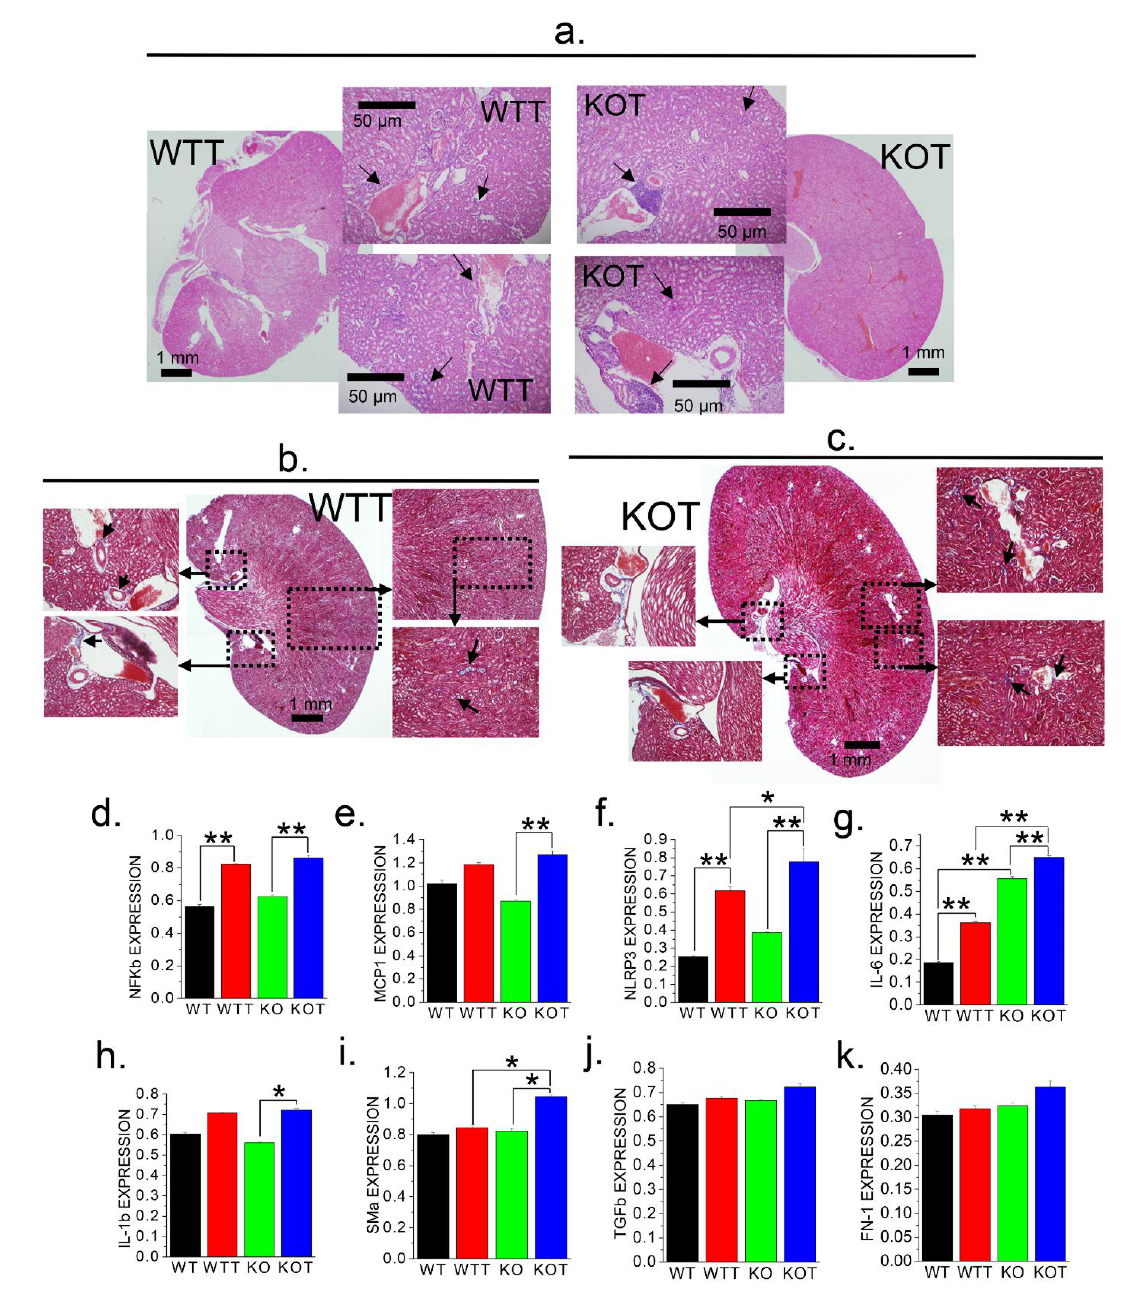
Figure 6. Histological and molecular characterization of kidneys for fibrosis and inflammation following Acz treatment . Supportive evidence of Acz-induced fibrotic and inflammatory induction with of expressions of genetic markers of fibrosis and inflammation in PT cells. ( a ) Representative H&E staining of KOT and WTT mice kidney sections showing regions of inflammation in the kidney. ( b , c ) WTT and KOT mice kidney sections of Masson’s Trichrome staining shows fibrotic regions of the kidney. Corroborative evidence through gene expression analysis for fibrotic and inflammatory markers ( d ) NF κβ , ( e ) MCP1, and ( f ) NLRP3 in WT, WTT, KO, and KOT mice PT cells which are significantly higher in the treated groups especially for KOT, compared to the controls. Genetic expression profiles of ( g ) IL-6, ( h ) 1L-1 β , ( i ) SM α , ( j ) TGF β and ( k ) FN-1 in WT, WTT, KO, KOT mice PT cells; except in TGF β and FN-1, KOT groups yielded higher expressions. ( d – k ) Bar graphs are means ± SEM from three separate experiments. *, p < 0.05; **, p < 0.01. All gene expressions are normalized to